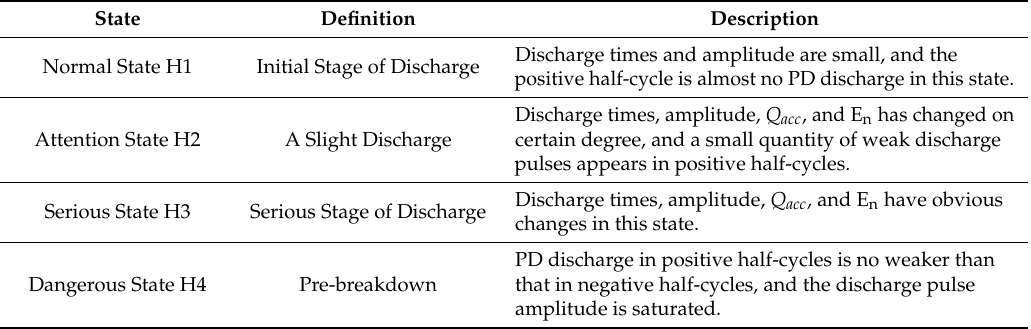
Table 4. Definition of the PD severity